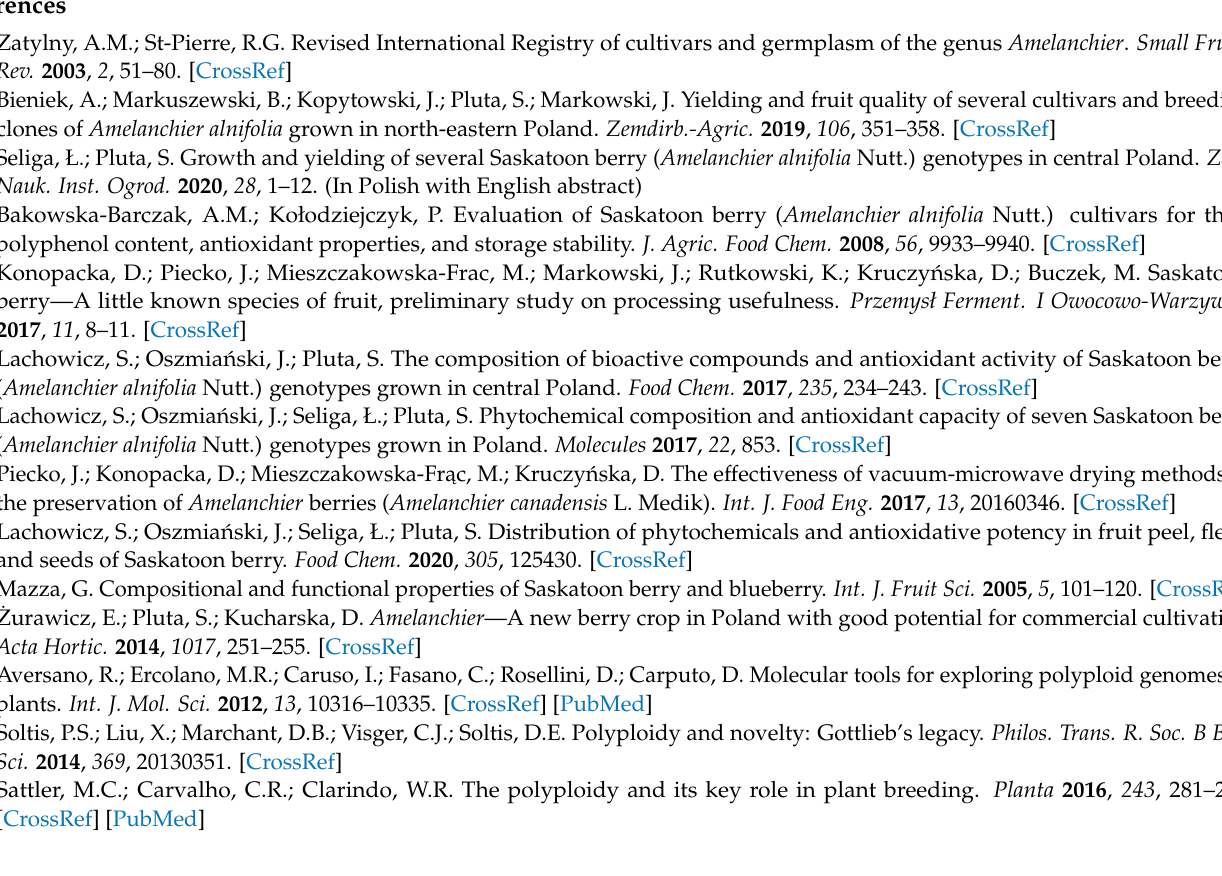
Table S1: Stages of obtaining, micropropagation, rooting and acclimatization of Saskatoon berry